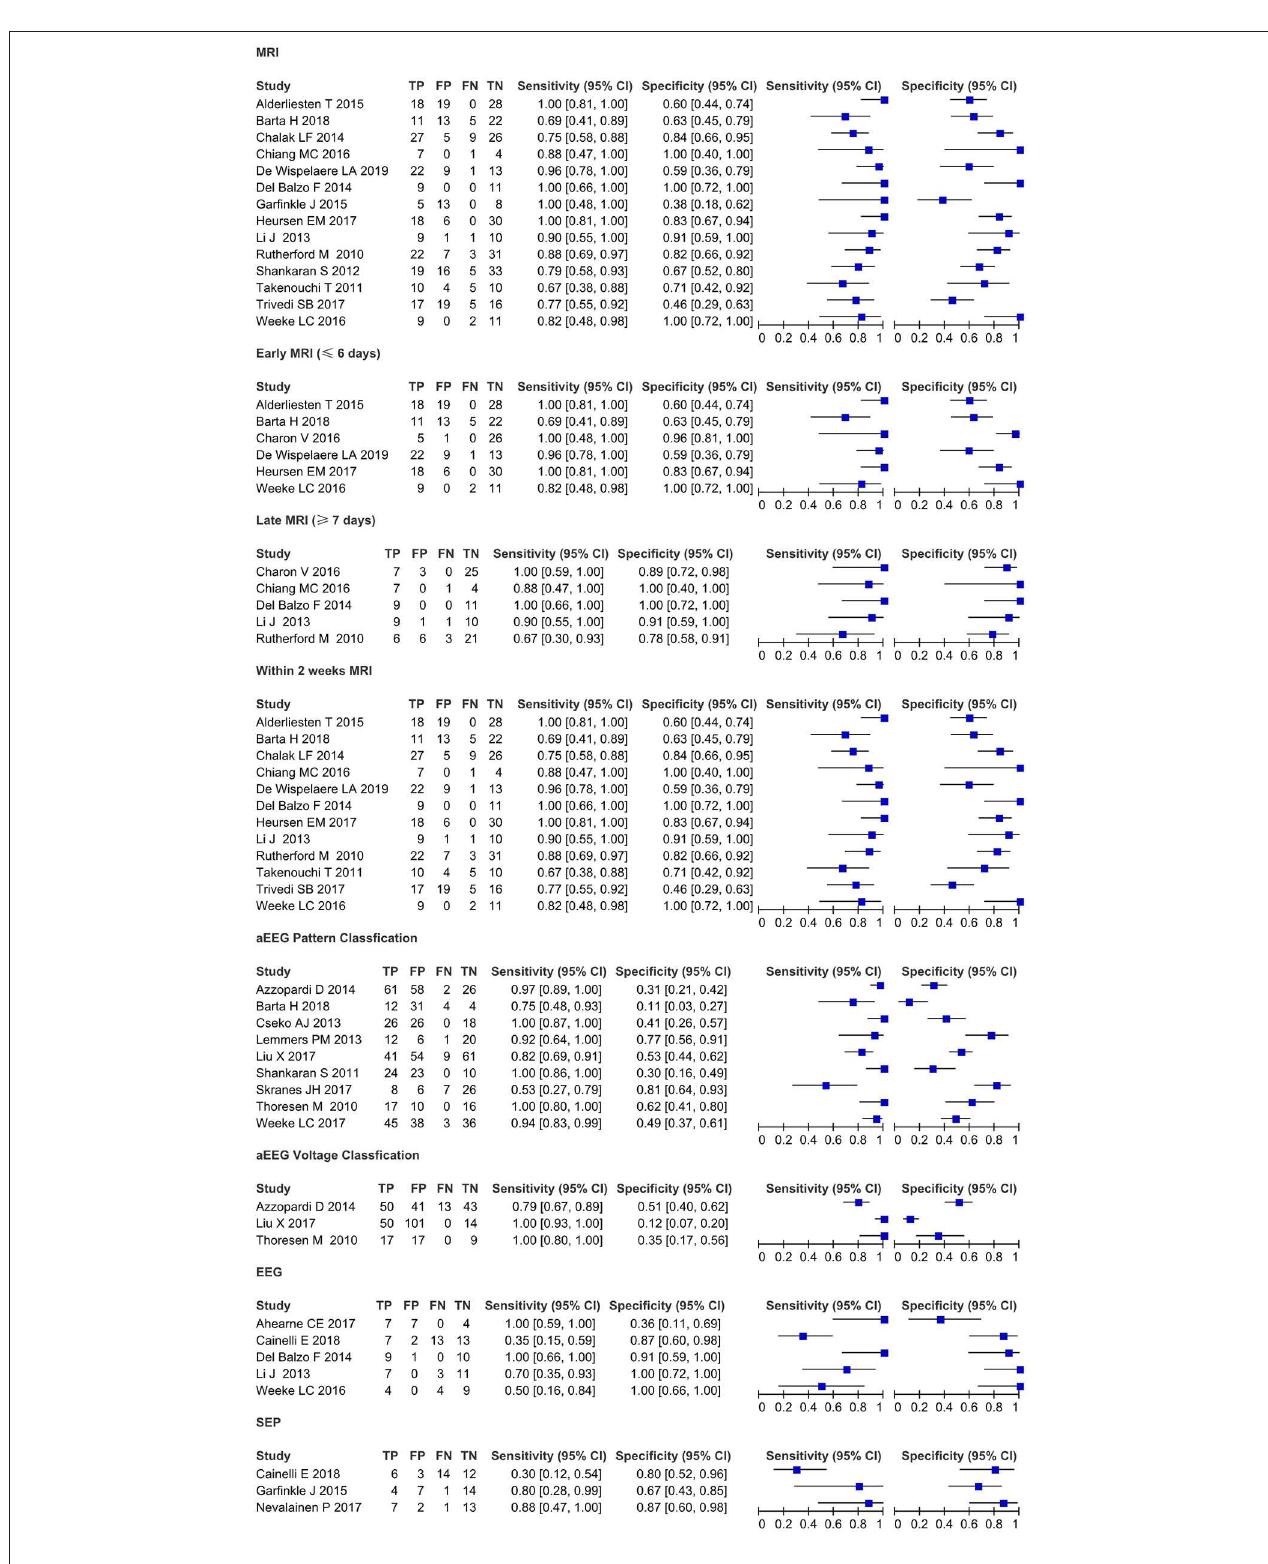
FIGURE 4 | Forest plots of sensitivity and specificity as calculated from the original reports.